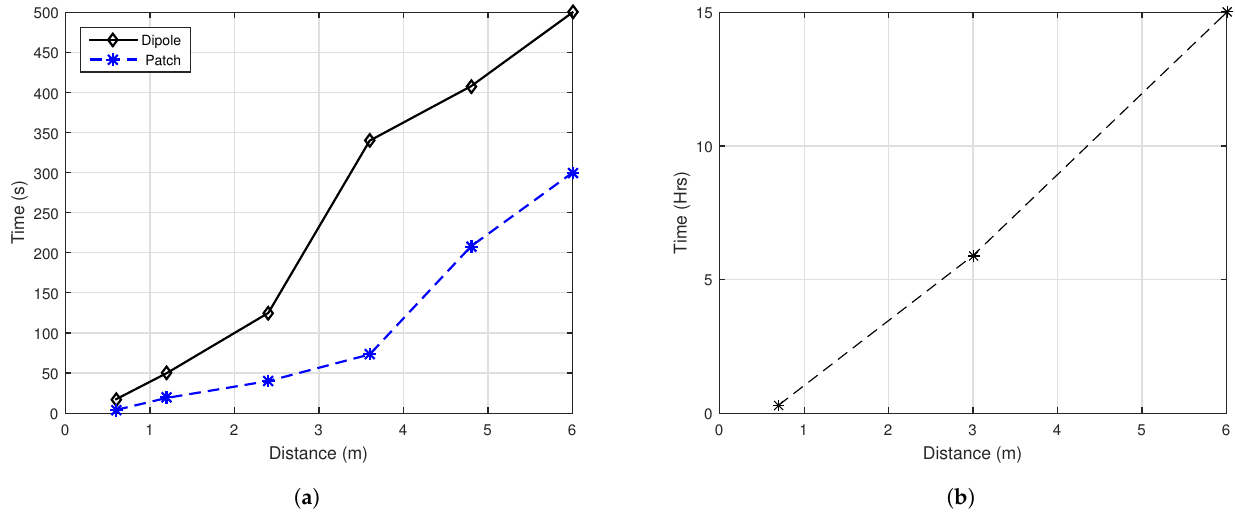
Figure 11. First charging time: ( a ) for the c5 built in capacitor (50 mF); ( b ) Charging 1F capacitor using patch antenna.